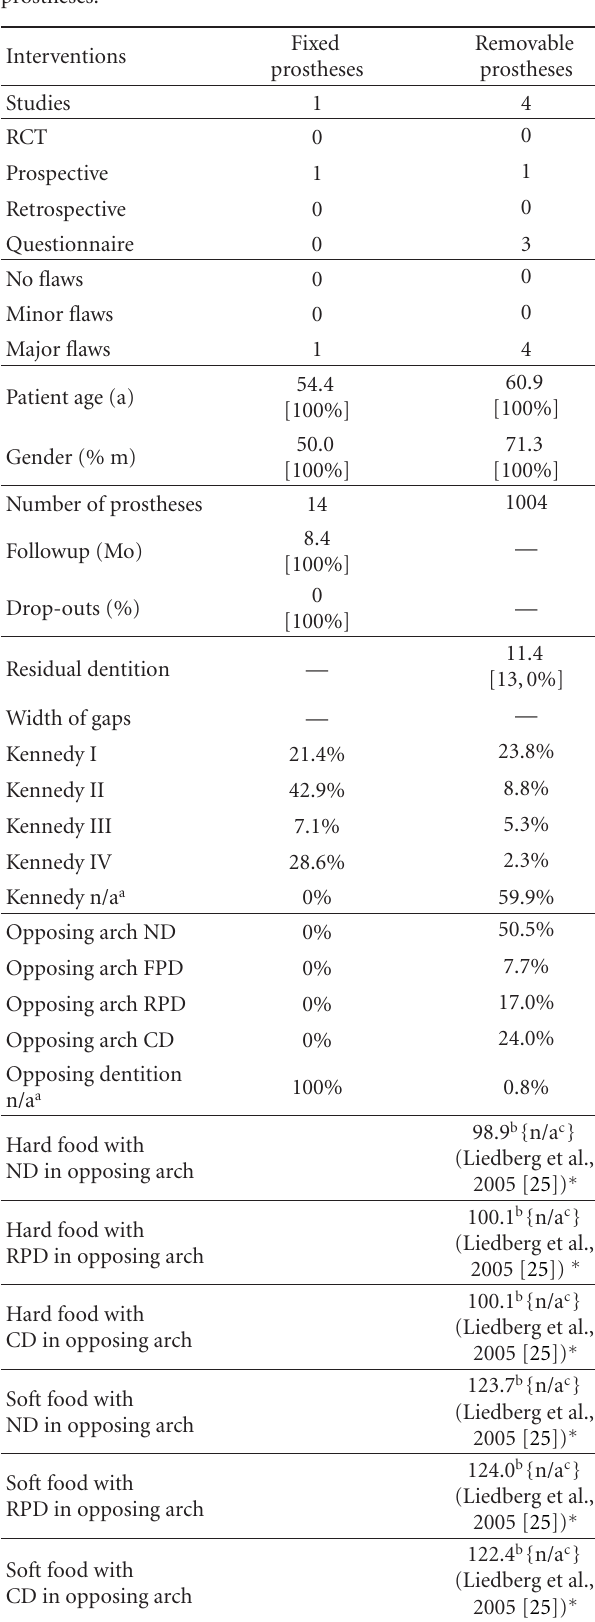
Table 9: Results on the eating habits of fixed and removable prostheses.